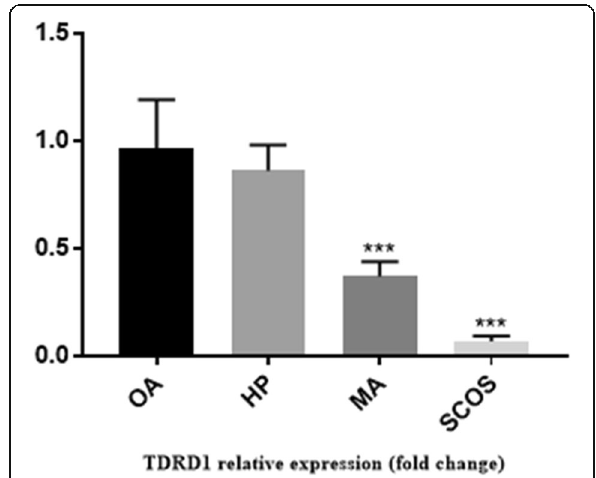
Fig. 3 Comparison of the expression levels of TDRD1 between HP, MA, SCOS, and OA(control) patients. *** p < 0.001